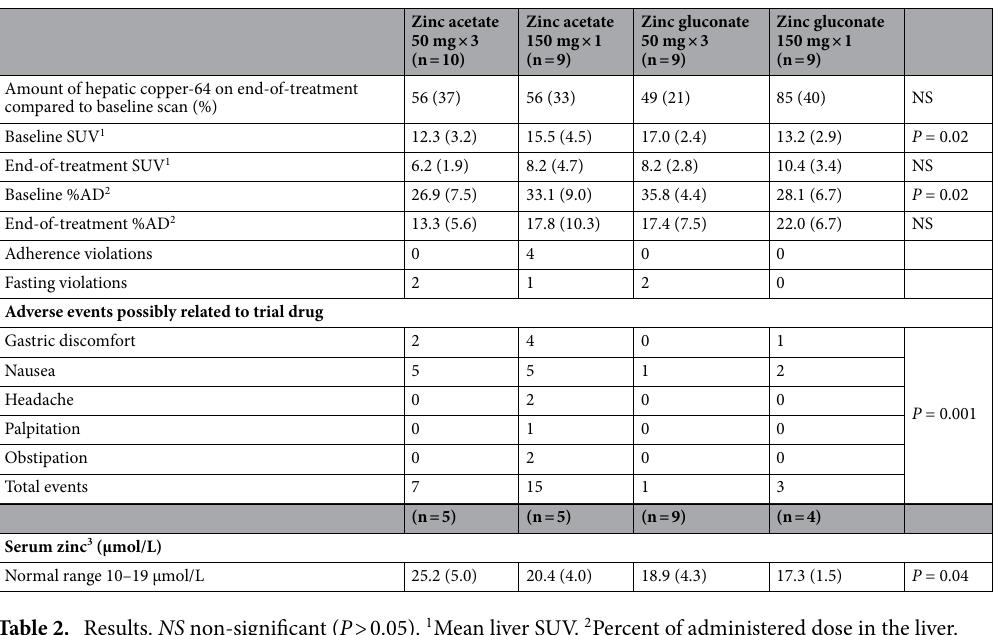
Table 2. Results. NS non-significant ( P > 0.05). 1 Mean liver SUV. 2 Percent of administered dose in the liver. 3 After zinc administration.